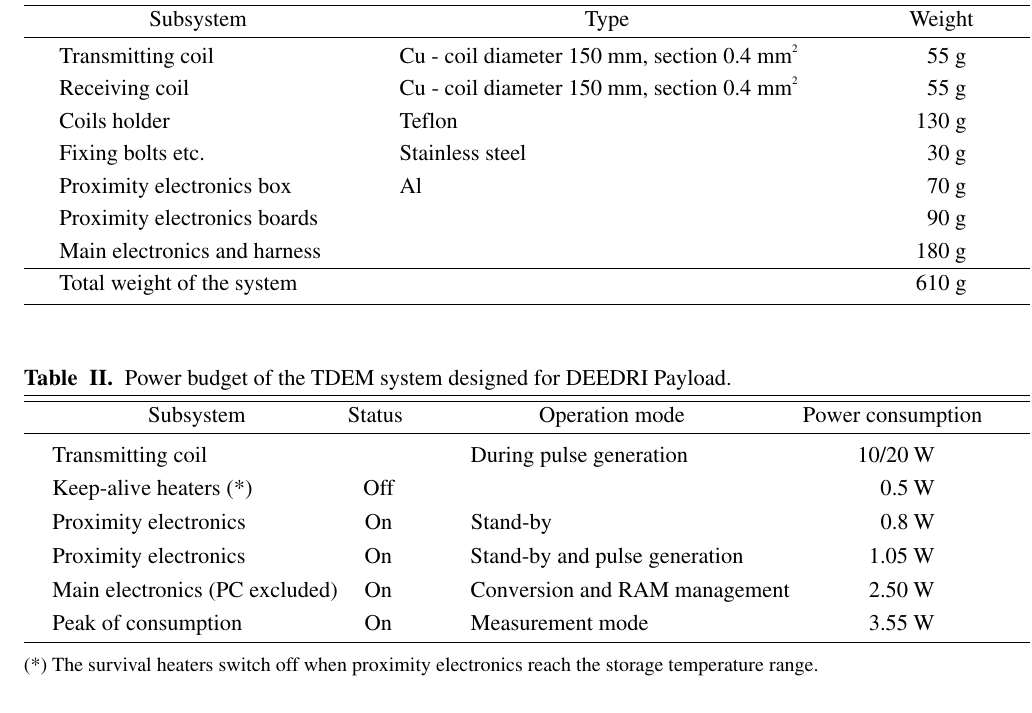
Table I. Mass budget of the TDEM system designed for DEEDRI